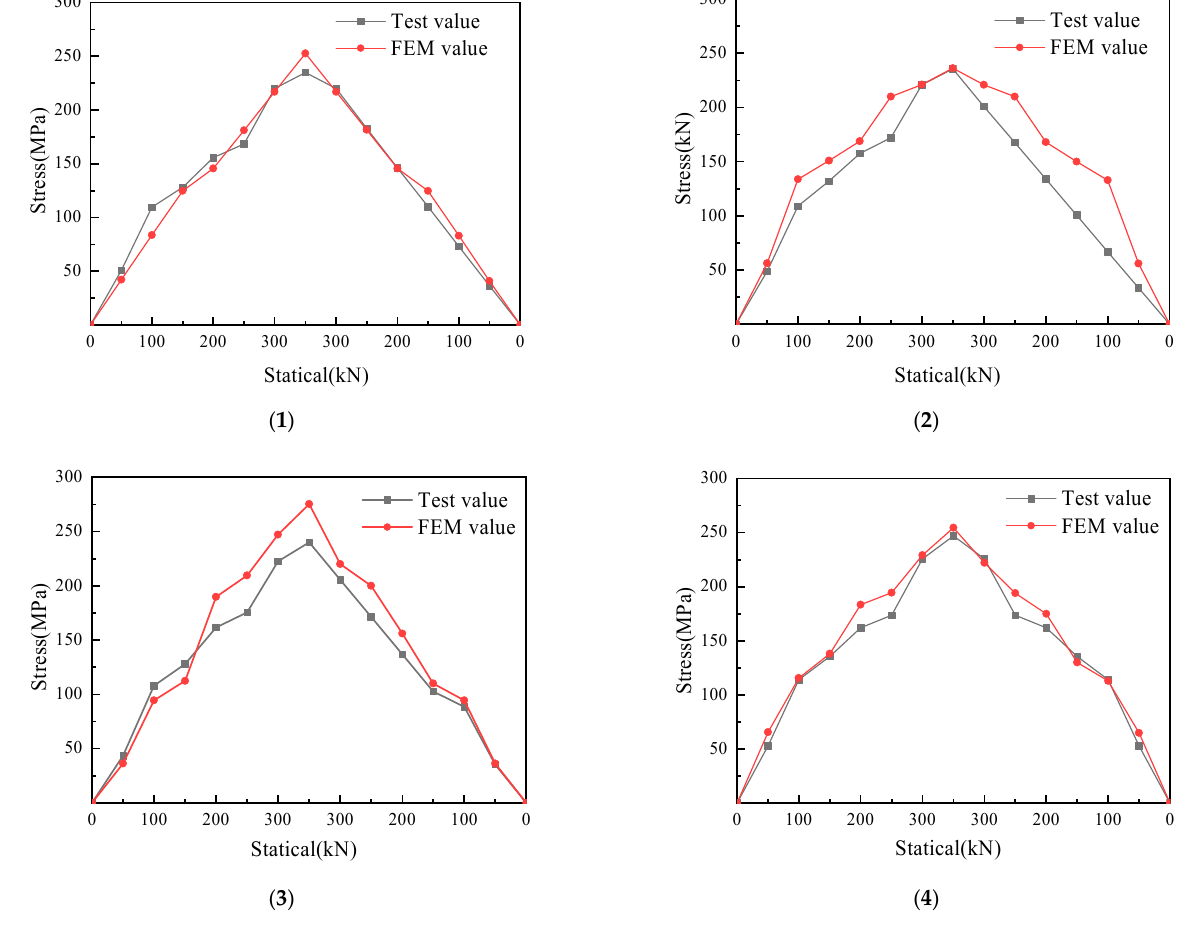
Figure 8. Stress comparison between test and FE model. ( 1 ) Strain gauge 1; ( 2 ) strain gauge 2; ( 3 ) strain gauge 3; ( 4 ) strain gauge 4.